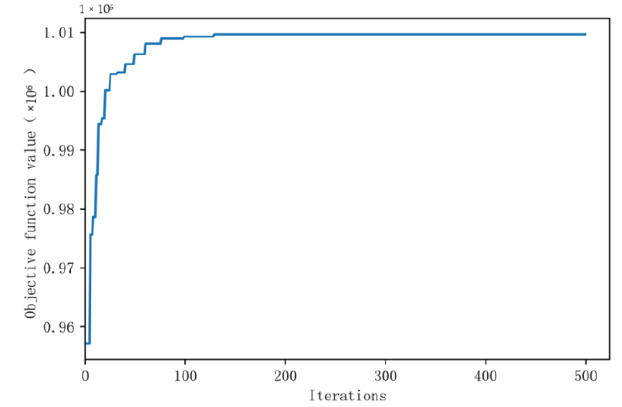
Figure 6. The iteration process.